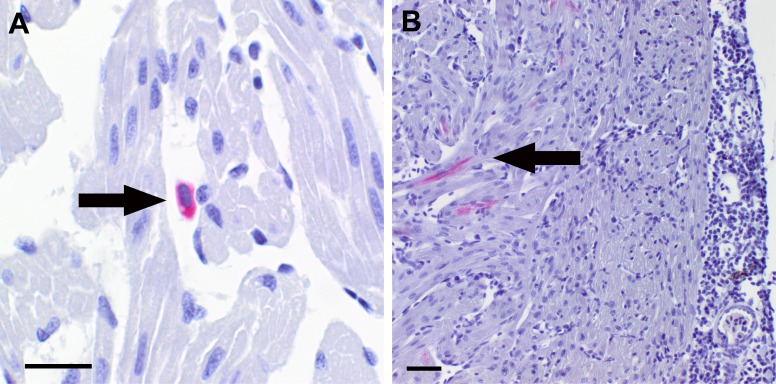
Immunohistochemical detection of PRV in heart sections of infected fish.Immunohistochemical staining of PRV in heart sections from the PRV-High group in challenge experiment #2, using σ1-antibodies. (A) Positive erythrocyte (arrow) detected at 2 wpc as even cytoplasmic staining (red). Scale bar 10 μm. (B) PRV antigen (red) detected in cardiomyotes (arrow) in the heart ventricle at 4 wpc. Scale bar 20 μm.